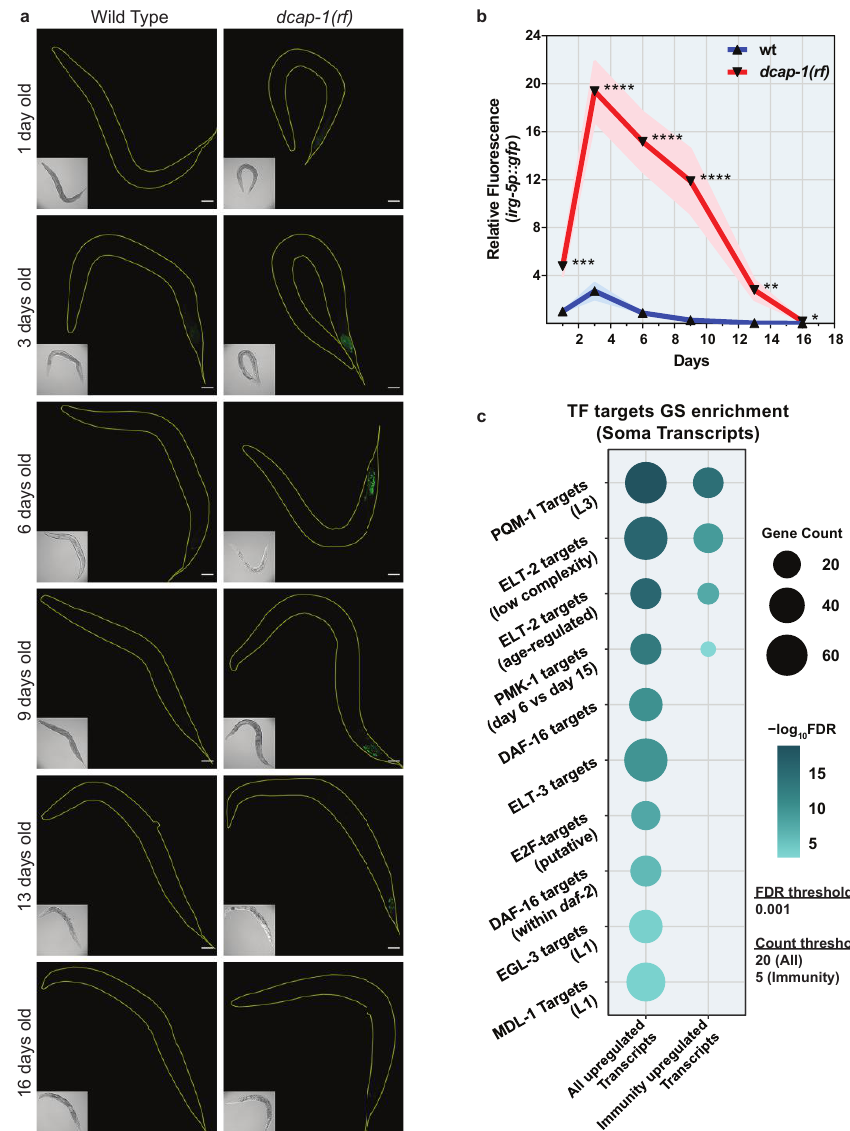
Figure 2. Reduced DCAP-1 function induces a transcriptional response. ( a ) Representative confocal images (maximum projections) of wt and dcap-1(rf) animals that express irg-5p::gfp at various ages. Scale bar = 50 µ m. ( b ) Relative fluorescence (mean ± SEM) of wt and dcap-1(rf) animals that express irg-5p::gfp at various ages. See also Figure S2. * p ≤ 0.05, ** p ≤ 0.01, *** p ≤ 0.001, **** p ≤ 0.0001. Unpaired t -test. ( c ) Gene set (GS) enrichment analysis for transcription factor (TF) targets in all upregulated somatic transcripts of dcap-1(rf) animals or in those related to immunity. Dot size corresponds to gene count in each category. Dot color corresponds to enrichment significance. See also Table